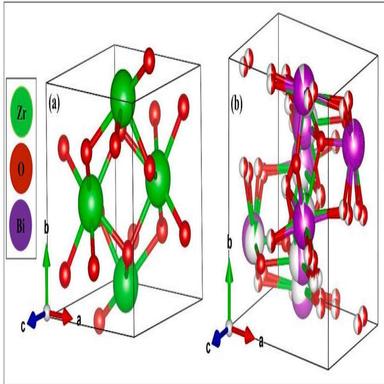
Crystal structure comparison of m-ZrO2 and Bi1.85Zr0.15O3.075.